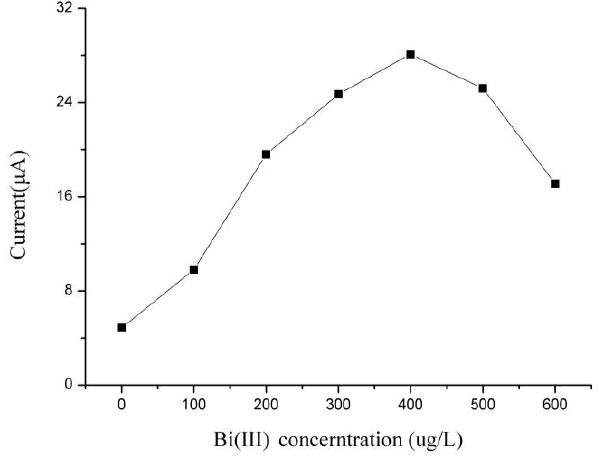
Figure 10. Effects of Bi(III) concentration on the stripping peaks current of 35 µg/L Cd(II).